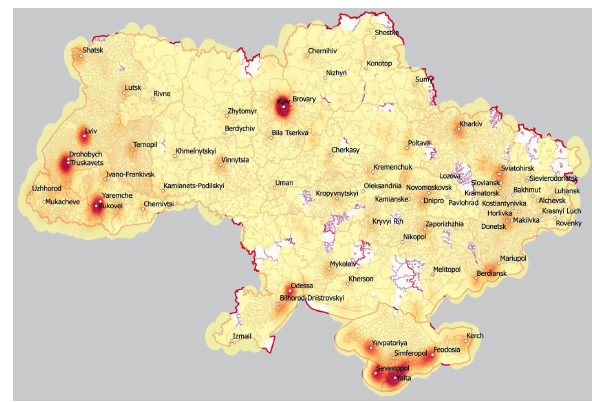
Figure 4. Point mapping of tourist objects on the map of Ukraine